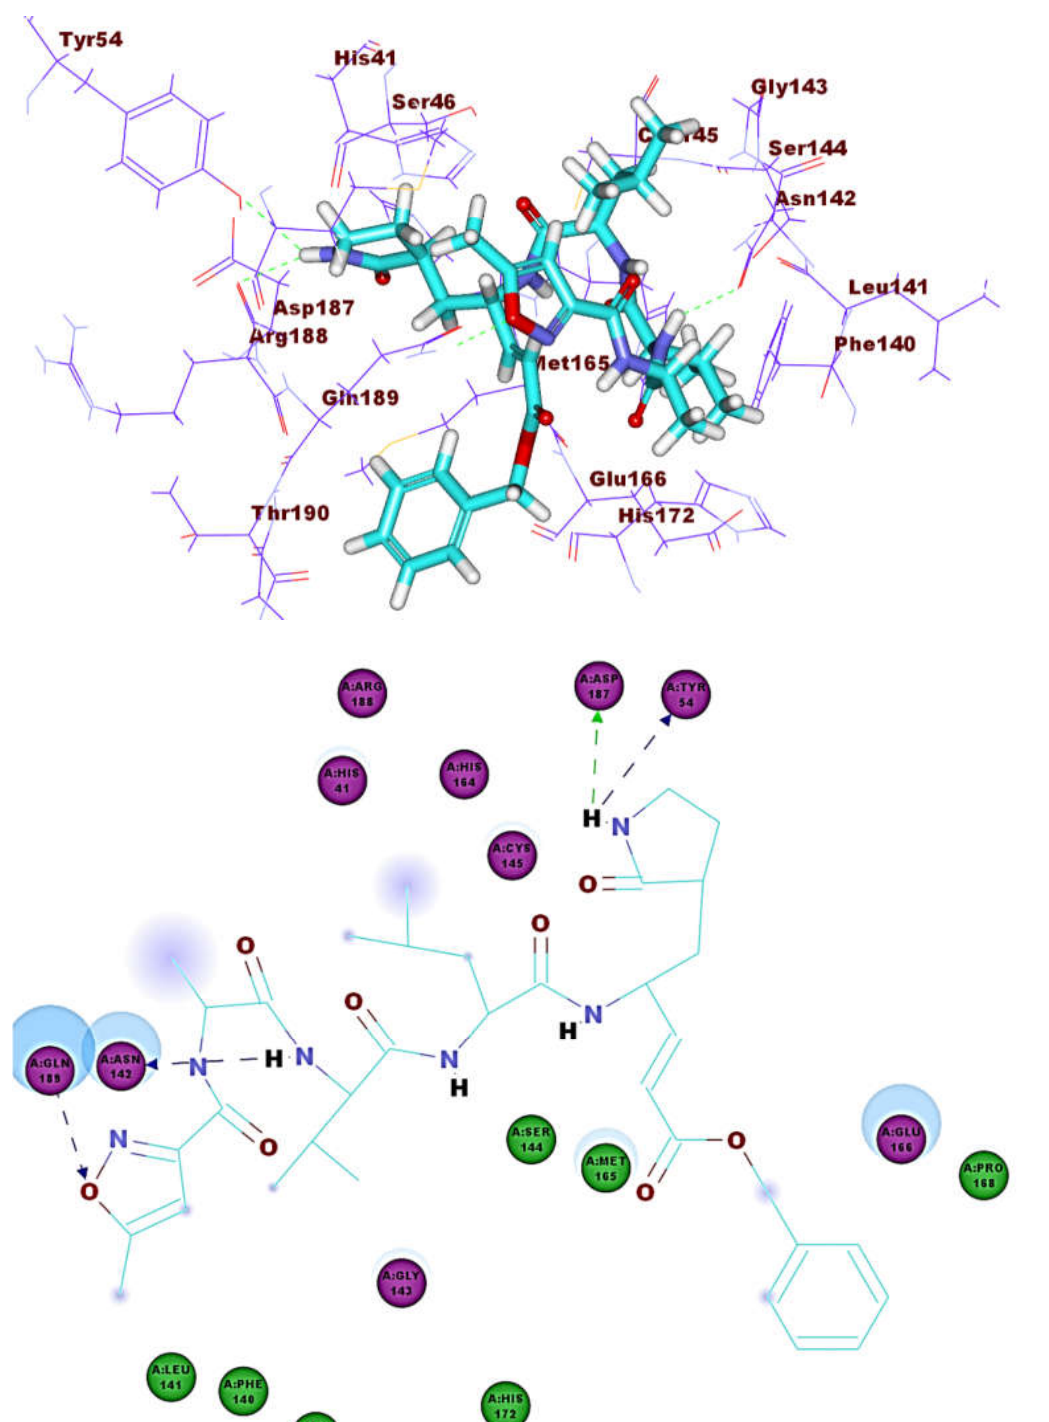
Figure 9. The co-crystallized ligand (N3) docked into M pro , forming four H. bonds with Gln189, Tyr 54, Asp 142, Asp187.